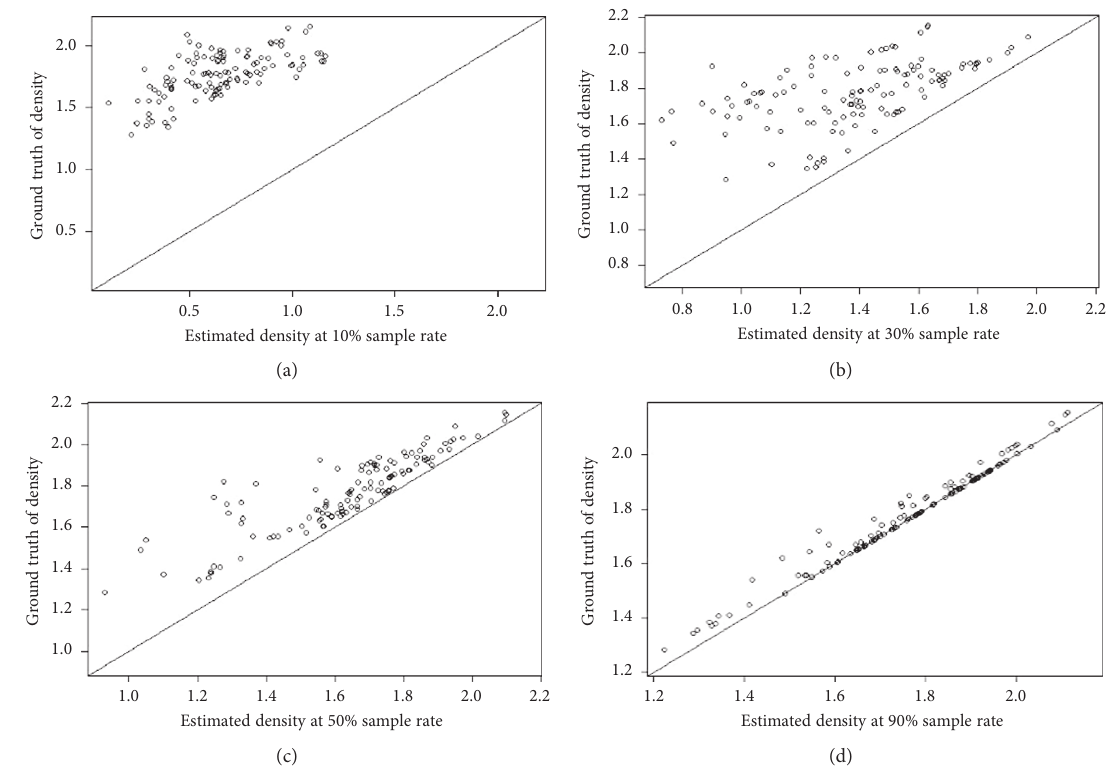
Figure 5: Scatter plot by sample rate of scenario 1 (numerical evaluation). (a) Scatter plot at 10% sample rate. (b) Scatter plot at 30% sample rate. (c) Scatter plot at 50% sample rate. (d) Scatter plot at 90% sample rate.